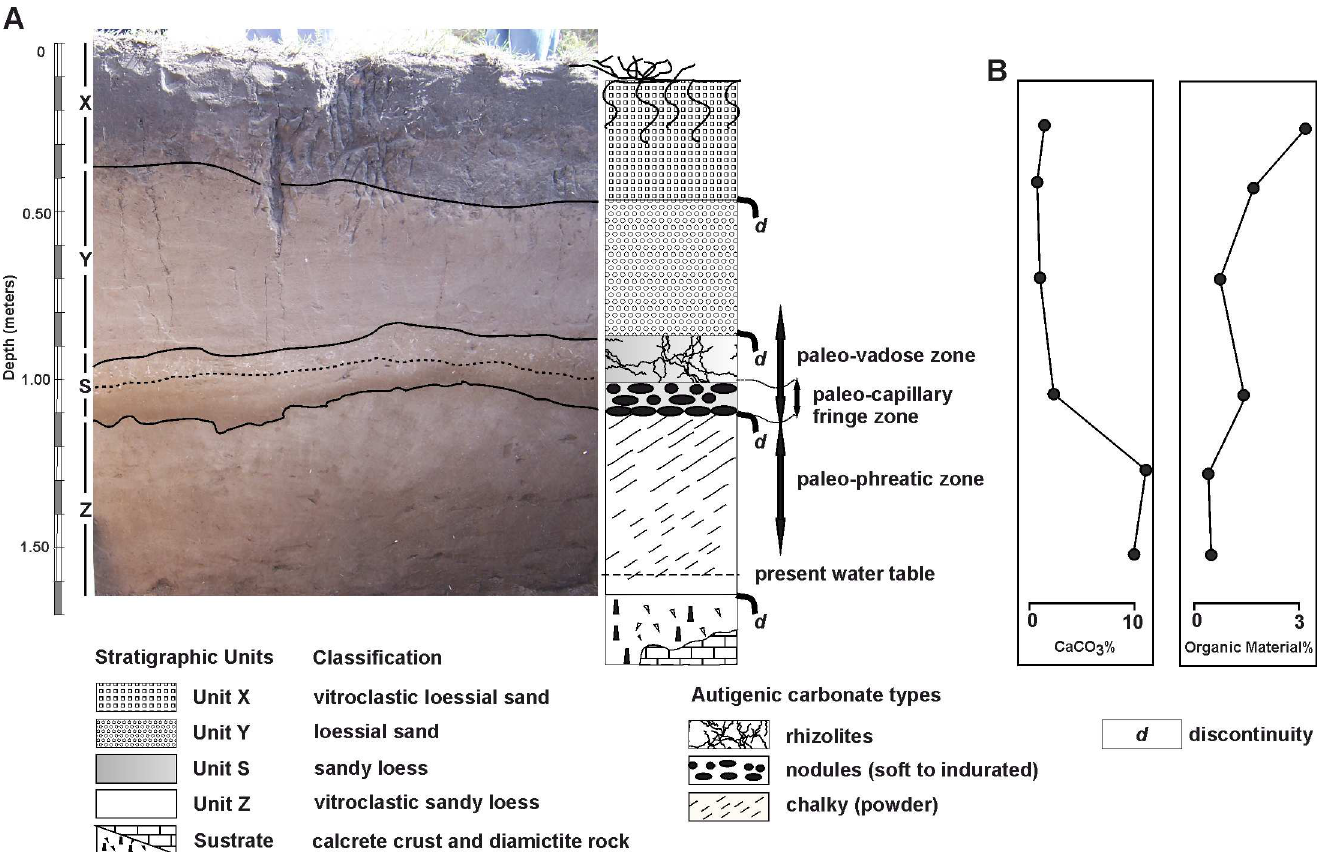
Fig 3. Geological contextof the Arroyo Seco 2 site. (A) Stratigraphic profilefromexcavation Unit 70 (southwall). (B) Calciumcarbonate(CaCO 3 ) and organicmaterialpercentages.